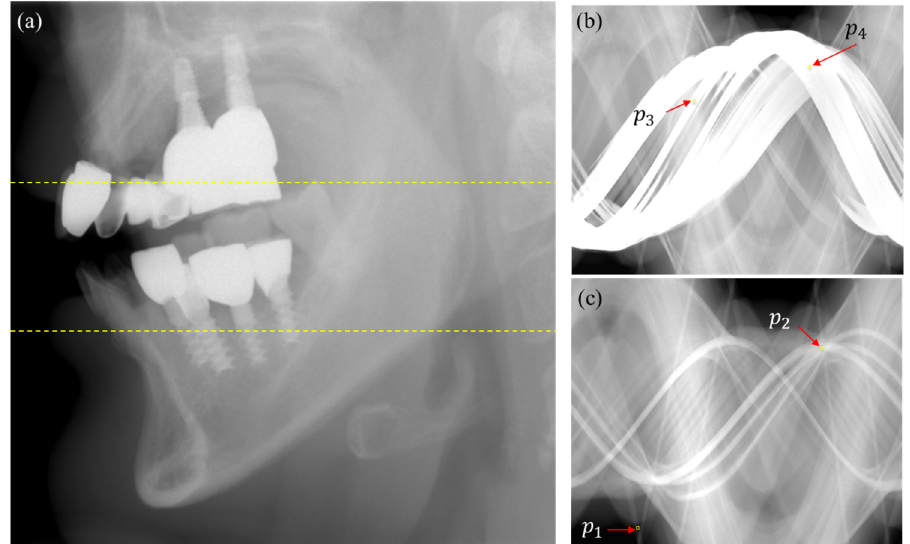
Figure 4. ( a ) An example of the projection image of a patient who has multiple dental implants and crowns. ( b ) A DSC sinogram made from the slice of the top dashed line. ( c ) A DSC sinogram made from the slice of the bottom dashed line.